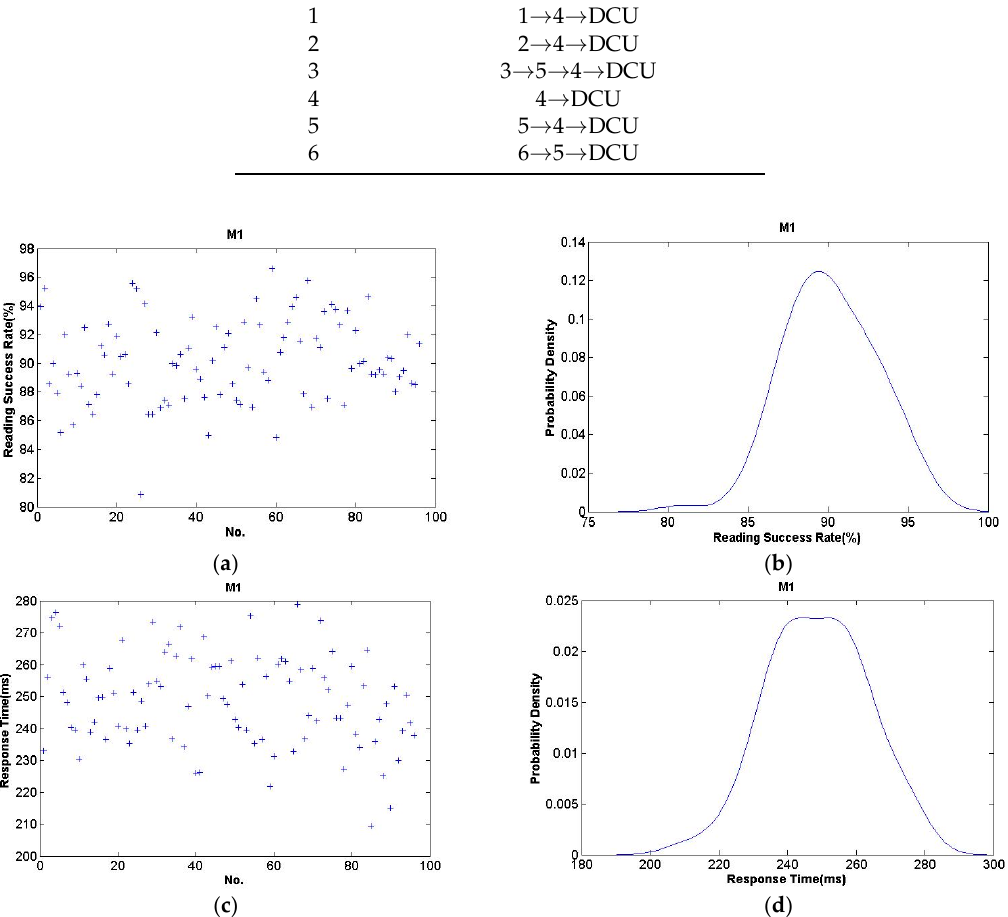
Figure 9. Measurements and PDs of M 1 . ( a ) Reading Success Rate; ( b ) PD of Reading Success Rate; ( c ) Response Time; ( d ) PD of Response Time.